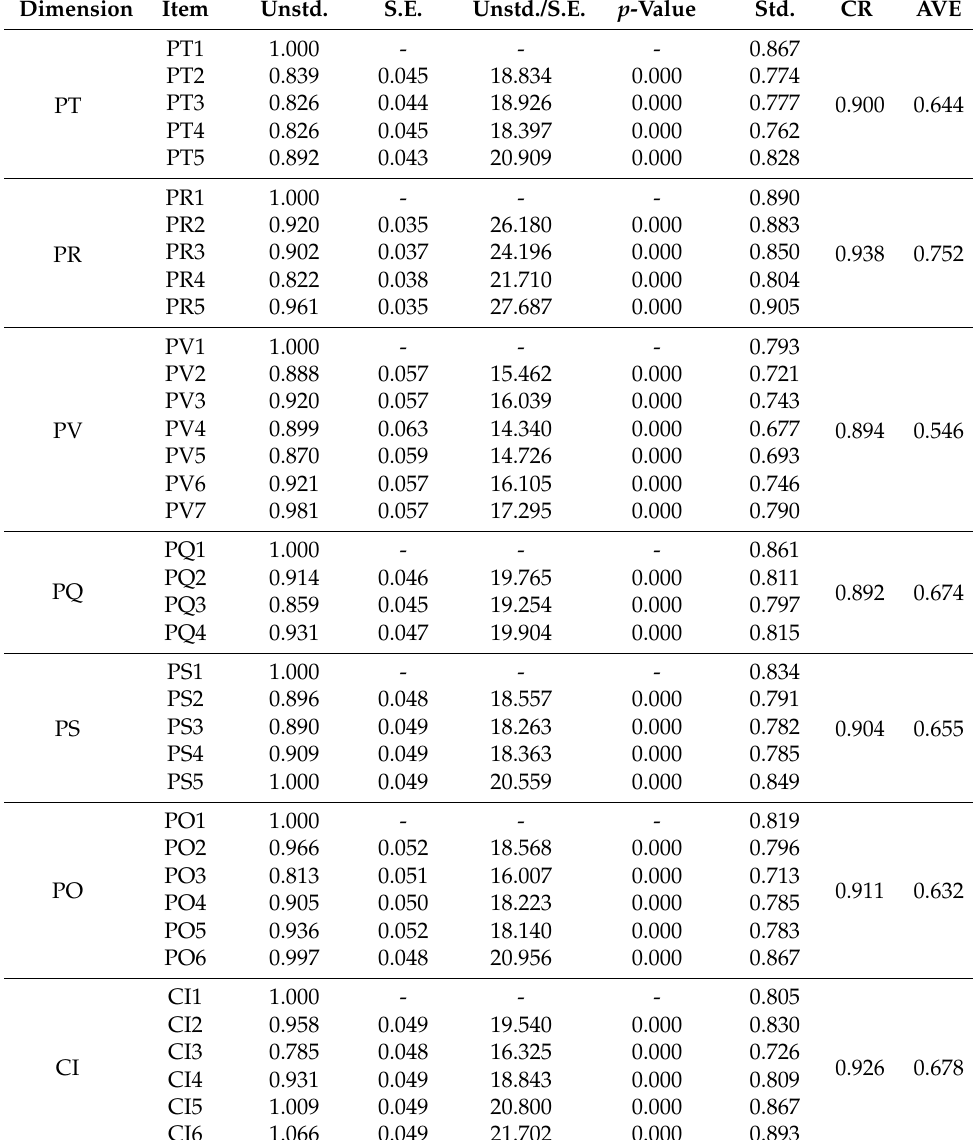
Table 4. Measurement